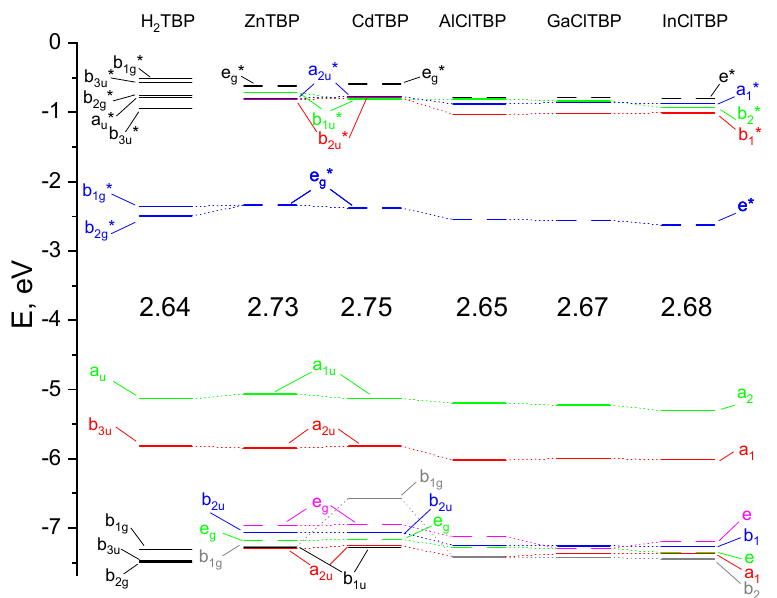
Figure 6. Molecular orbital (MO) level diagram for H 2 TBP and MTBP complexes. The values of higher occupied molecular orbital–lowest unoccupied molecular orbital (HOMO–LUMO) gaps are given in eV.